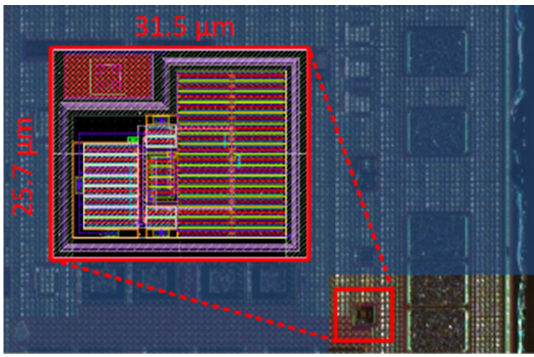
Figure 2. Layout and chip microphotograph of the proposed OTA.